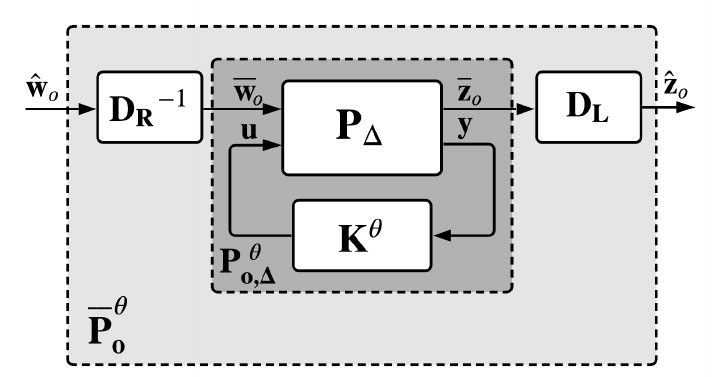
Figure 2. The augmented plant with uncertainties P ∆ in LLFT connection with controller K θ forms the closed-loop plant P θ . After each D -scale step, the plant used to find the controller parameters o , ∆ is P θ o .